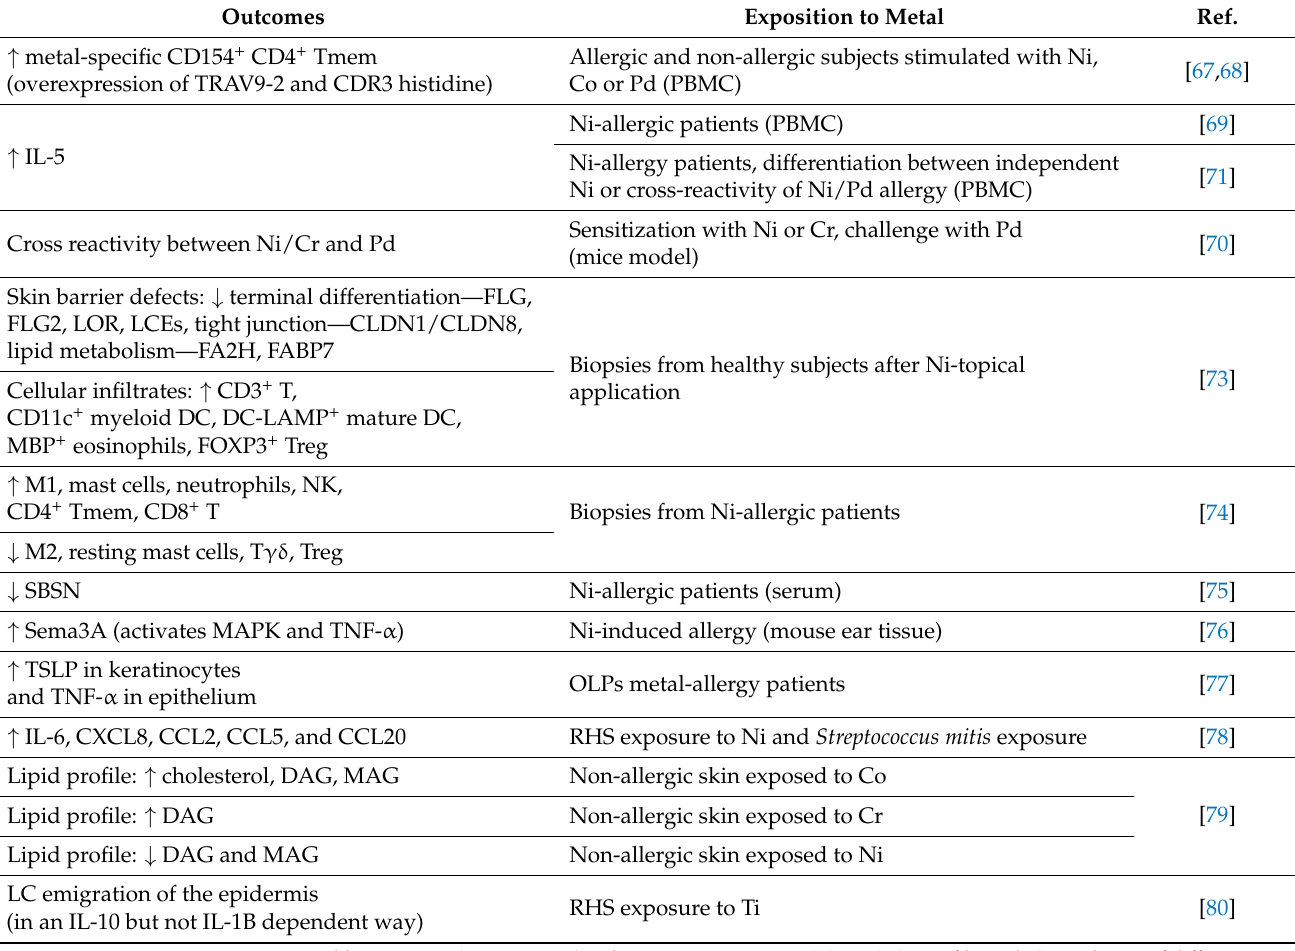
Table 1. Key advances in metal allergy mechanisms and